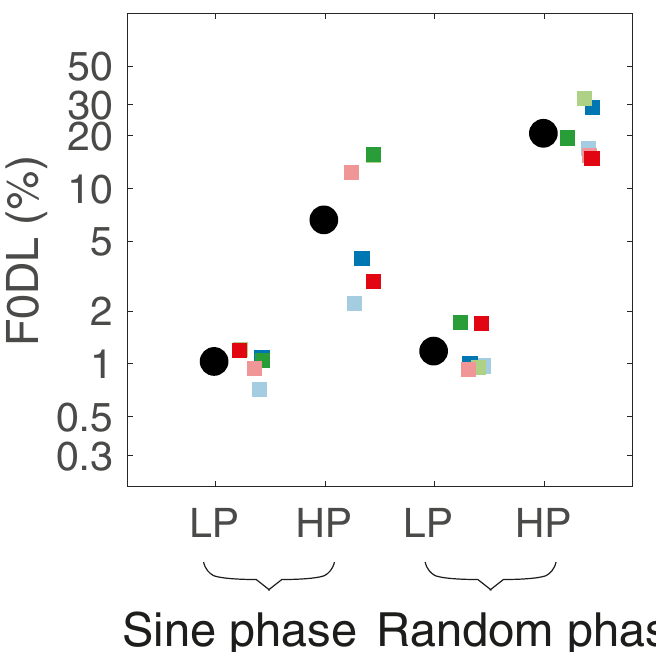
Fig 3. F0 discrimination thresholds. Thresholds for complex tones with components added in sine (left) or random (right) phase and under lowpass- or highpass-filtered conditions. Larger black circles represent mean thresholds, and the smaller colored symbols represent individual